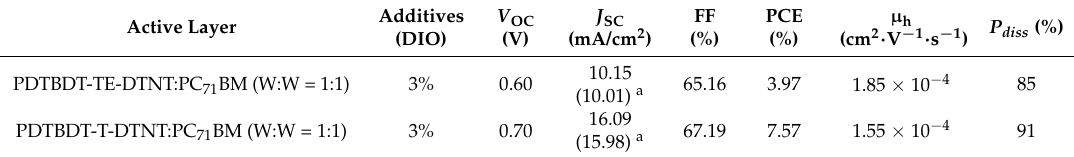
Figure 6. The optimized current density-voltage ( J - V ) curves ( a ) and the IPCE spectra ( b ) of the i-PVCs from the copolymers blend film under AM 1.5G illumination (100 mW/cm 2 ). Table 2. Parameters of i -PVCs with PFN as cathode layers from the copolymers. Active